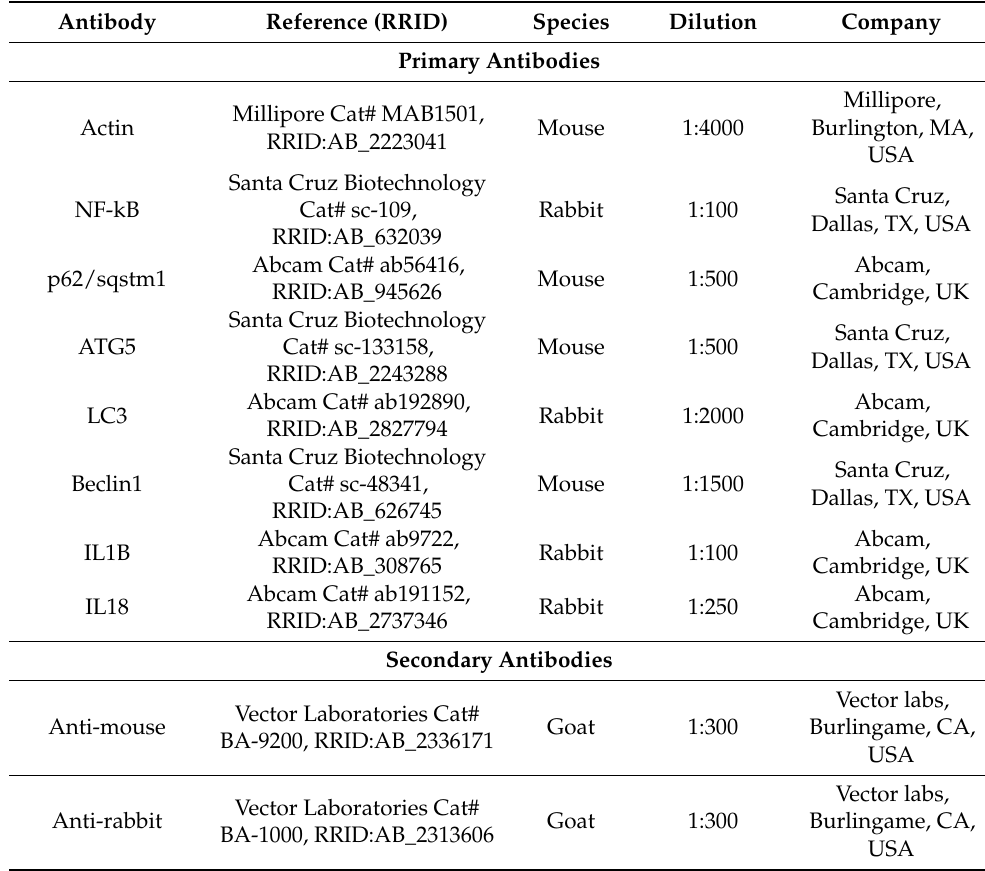
Table 2. Antibodies used for the Western